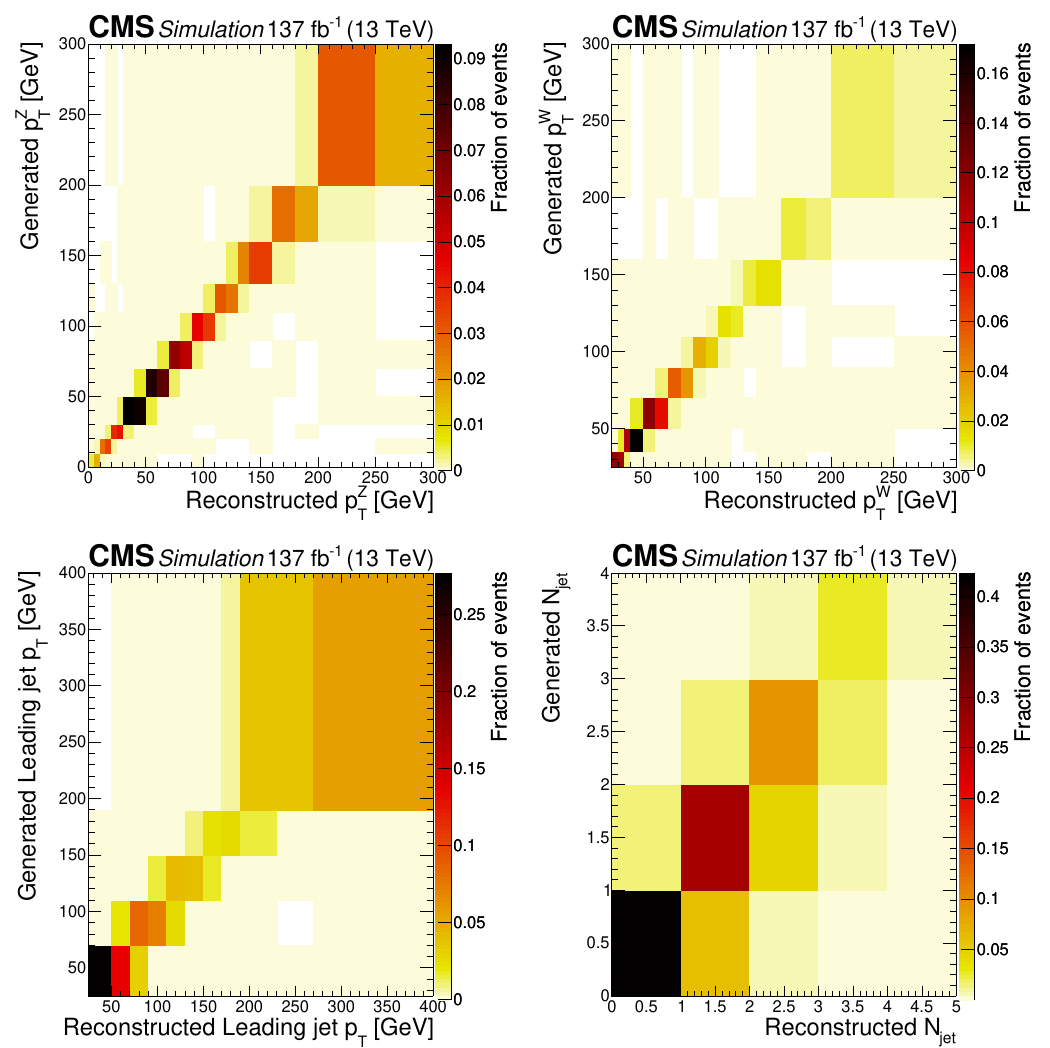
Figure 12 . Response matrices obtained at NLO in QCD using the powheg generator. Recon- structed p of the Z boson (top left, condition number 7.77), p of the lepton from the W boson T T decay (top right, condition number 20.9), p of the leading jet (bottom left, condition number 9.69), T and jet multiplicity (bottom right, condition number